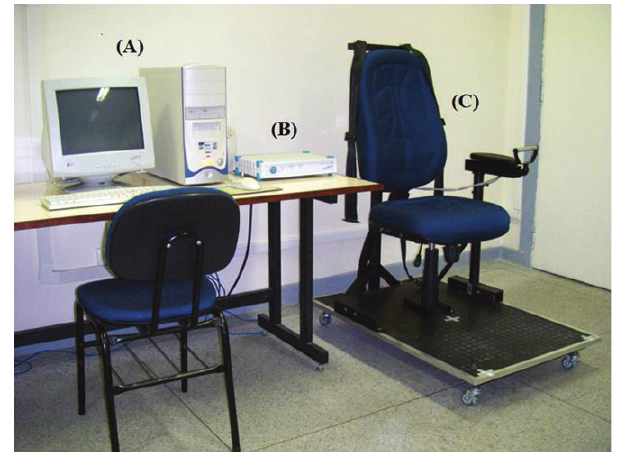
Figure 1 - System acquisition: (A) PC, (B) System acquisition and signal conditioning model SPIDER 8 and (C) Strength Measuring Station (SMS).